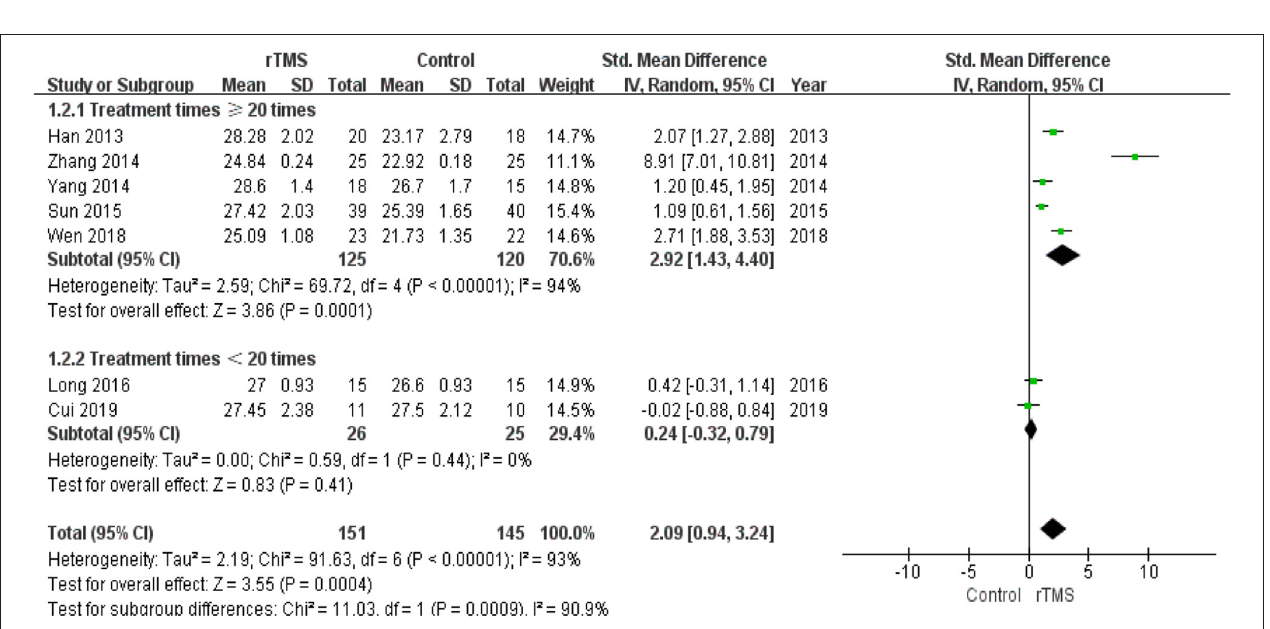
used for the meta-analysis. Meta-analysis showed no significant differences (SMD − 0.19, 95% CI − 0.61 to 0.22, p = 0.36,